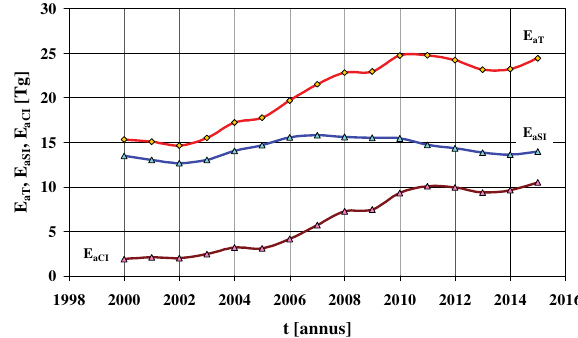
Fig. 11. National annual emission of ammonia from passenger cars